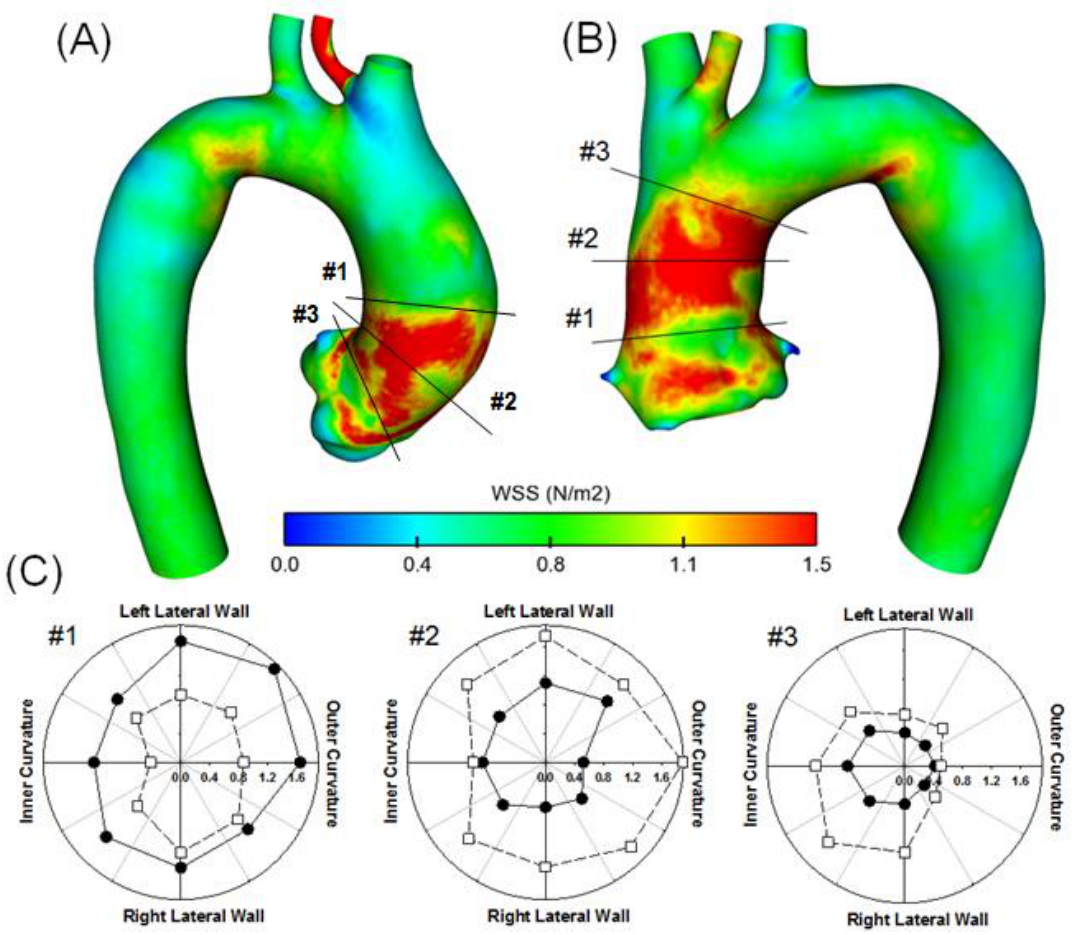
Figure 3. Map distribution of wall shear stress (WSS) at systole for ( A ) pre-operative model and ( B ) post-operative model after aortic resection; ( C ) planewise analysis of WSS using polar plots in 3 planes along ascending aorta for pre-operative ( ●) and post - operative (□) models .